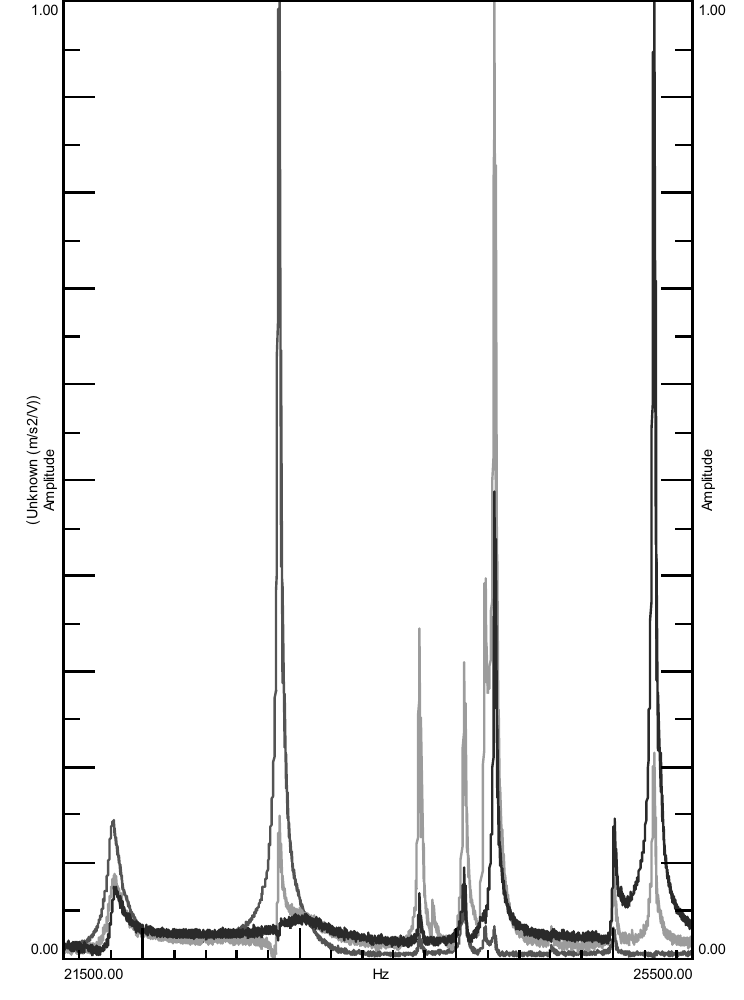
Fig. 13. Acquired FRFs blade 3, 6,